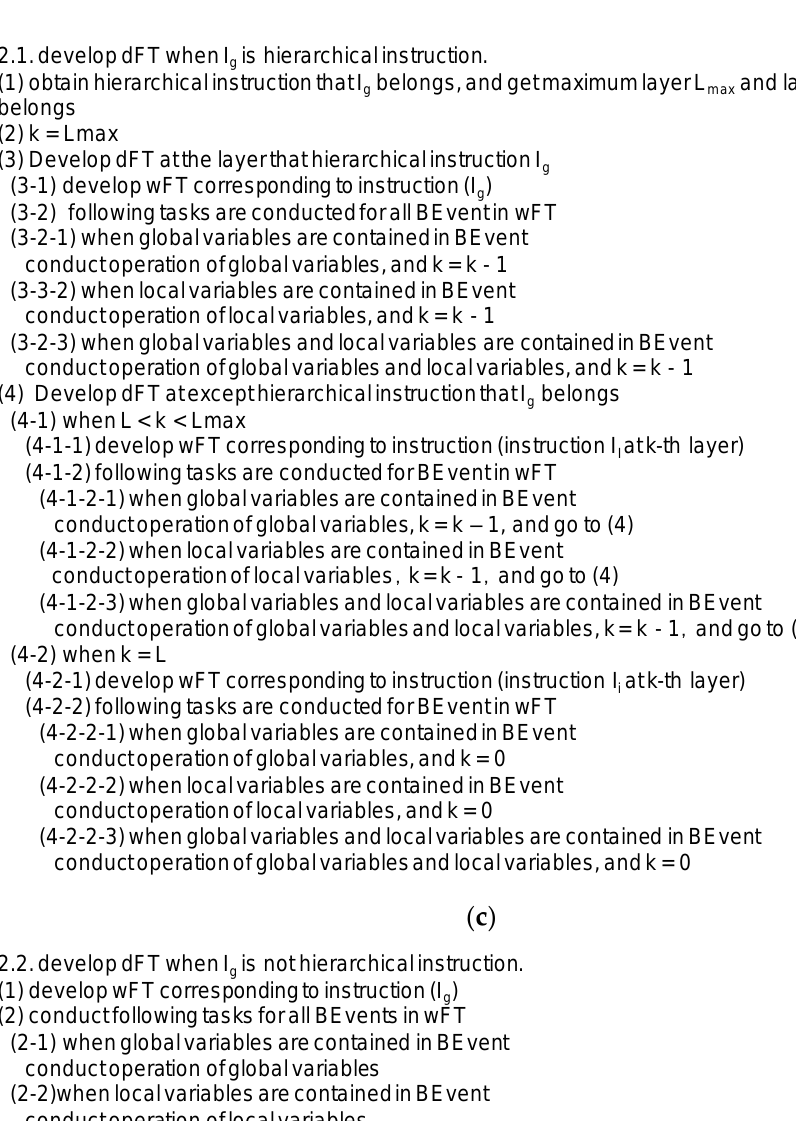
Figure 7. ( a ) FT development rules — Outline. ( b ) FT development rules — Detail of Develop FT module. ( c ) FT development rules — Detail of “ Develop dFT ” when I g is hierarchical. ( d ) FT development rules. — Details of “ Develop dFT ” when I g is not hierarchical.